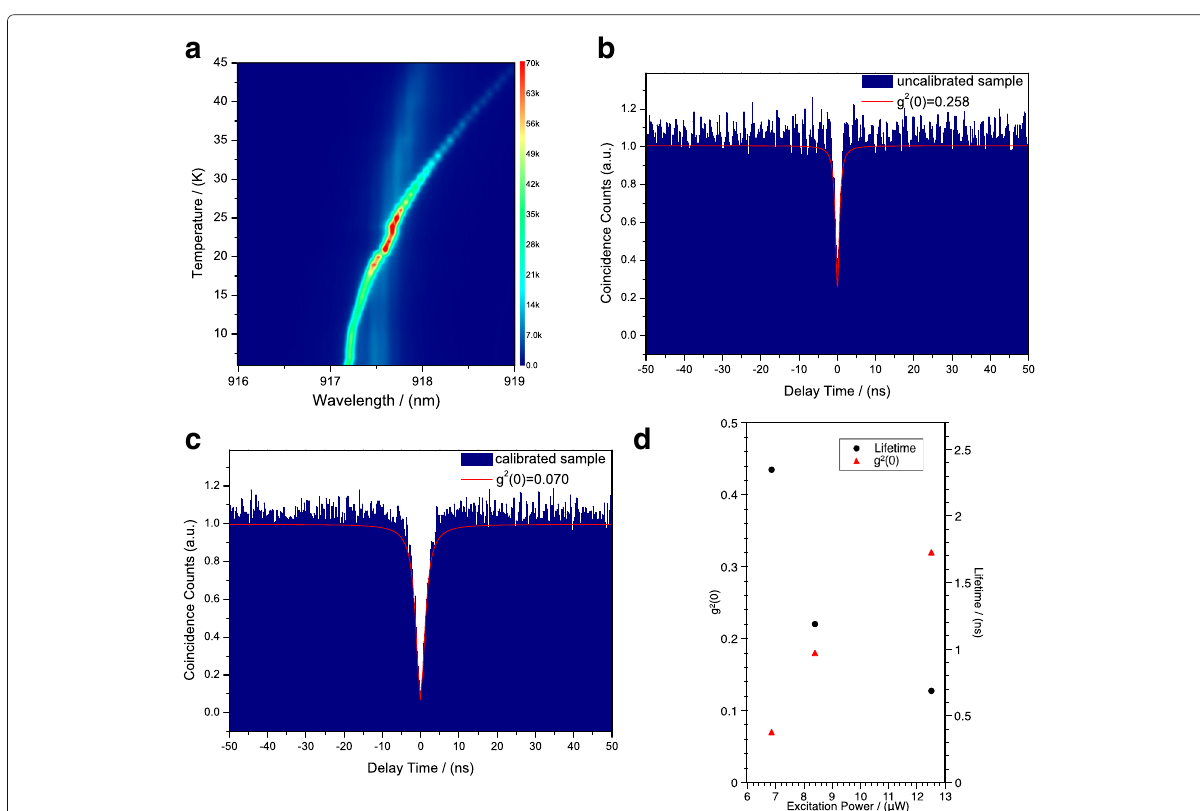
Fig. 3 a Contour of temperature-tuned PL spectra of the uncalibrated sample from 6.0 to 45.0 K. The second-order correlation function g ( 2 ) (τ) of the QD exciton (X) line under CW excitation of the sample without the calibration process ( b ) and the calibrated sample ( c ). d The radiative lifetime and g ( 2 ) ( 0 ) of the exciton emission for the calibrated sample under different excitation